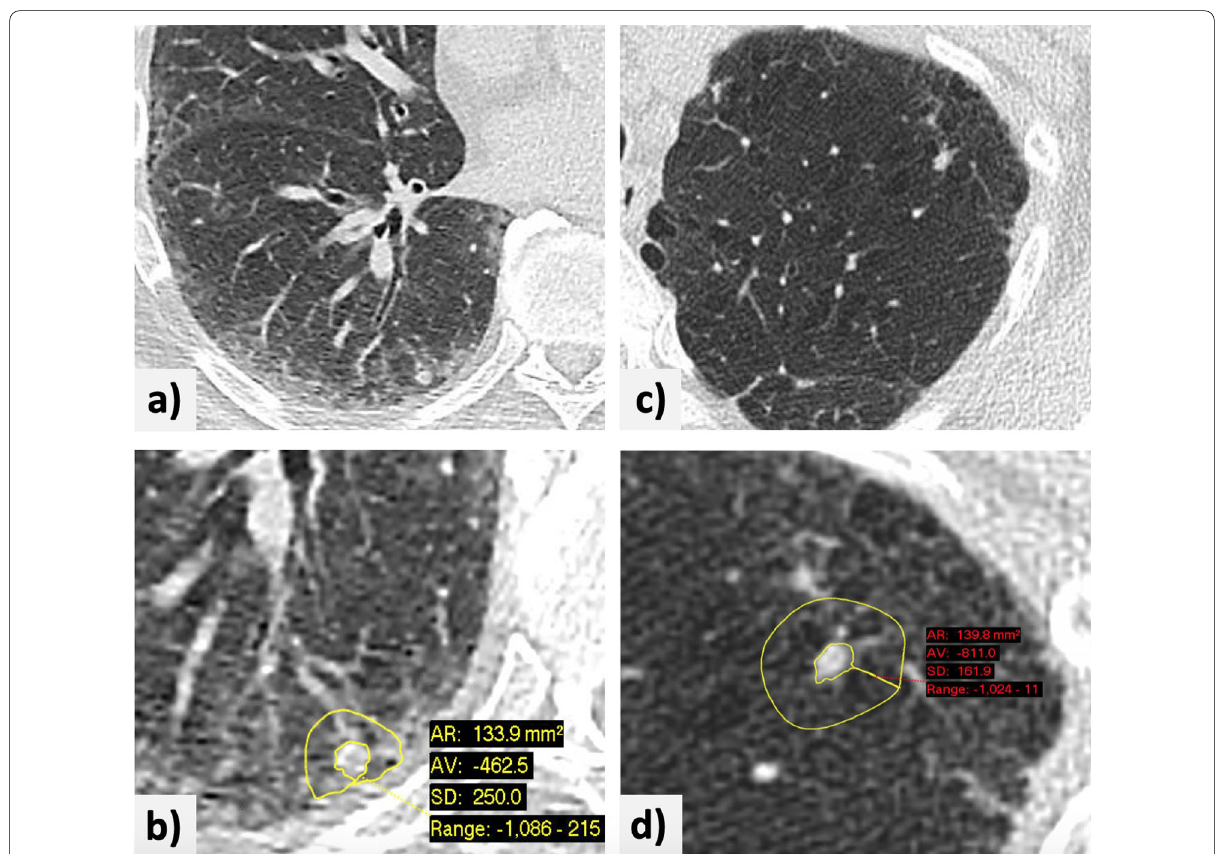
Fig. 2 Examples of the measurement of lung nodules in lung parenchyma with attenuation changes. a A small subpleural nodule in the right lower lobe of the lung of a patient with known interstitial lung disease. b The nodule is shown with a region of interest drawn manually around it, with a rim of about 5‑mm thickness. The average attenuation of the adjacent lung parenchyma on this slice is 462.5 HU. c A nodule in the anterolateral − aspect of the left upper lobe of the lung in a patient with known centrilobular and paraseptal emphysema. d Manual measurement of the average attenuation of the surrounding lung parenchyma ( 811 −